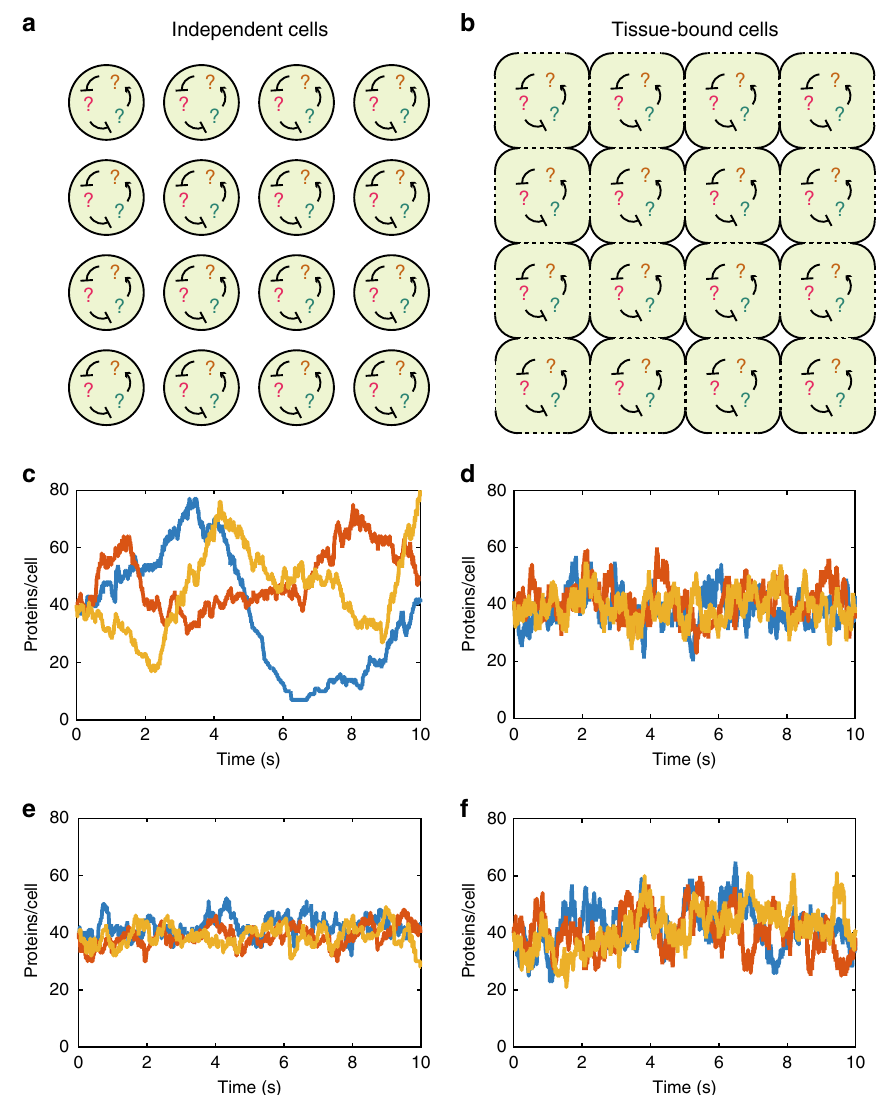
Fig. 1 Differences between a population of isolated cells and a tissue of cells. a A population of isolated cells: each cell contains an identical genetic network. b A tissue of cells: each cell contains an identical genetic network and some molecules can be transported between neighbouring cells (dotted lines). c Typical single-cell protein trajectories of system (1) in isolated cells. d Typical single-cell protein trajectories of system (1) in a tissue of connected cells: noise is clearly reduced compared to c . e Typical single-cell protein trajectories of system (3) in isolated cells. f Typical single-cell protein trajectories of system (3) in a tissue of connected cells: noise is clearly increased compared to e . Parameter values are v 0 = 4, d 0 = 1, v 1 = 10, d 1 = 1, t = 10, N 2 = 100, V C = 1 for system (1) and k = 32, k = 0.01, t = 10, N 2 = 100, V = 1 for system 1 2 C We simulated system (2) with a version of the SSA 31 with N 2 = typical single-cell trajectories of the protein P are plotted in 100 cells, giving 100 trajectories of protein number, one for each Fig. 1e, f respectively. The independent cell trajectories are cell. Three typical trajectories are plotted in Fig. 1d. Notably, the relatively homogeneous, while the tissue-bound cell trajectories tissue trajectories in Fig. 1d are considerably less variable (more homogeneous) than the isolated cell trajectories in Fig. 1c. are substantially more variable (more heterogeneous).